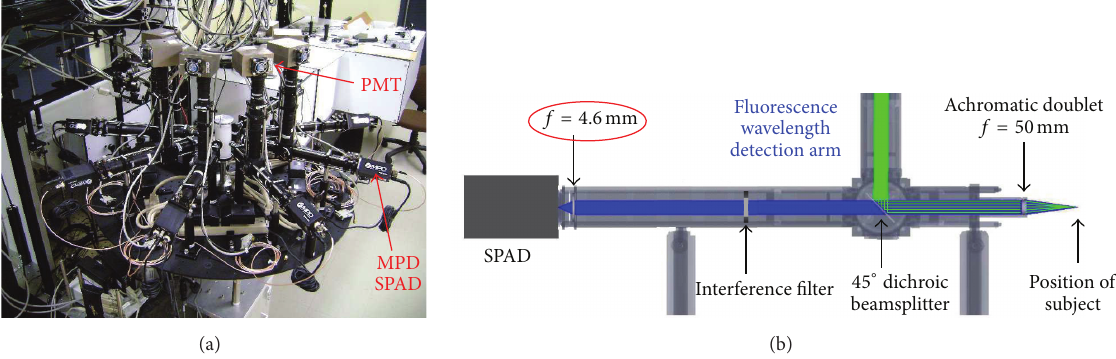
Figure 15: Photograph of the scanner where SPADs replace PMTs in the fluorescence arms of the detection channels (a). Schematic of the fluorescence arm of a detection channel modified for a SPAD detector (b). Essentially, a 50 mm focal length lens has been replaced by a much smaller focal length lens of 4.6 mm, and the lens tube was made